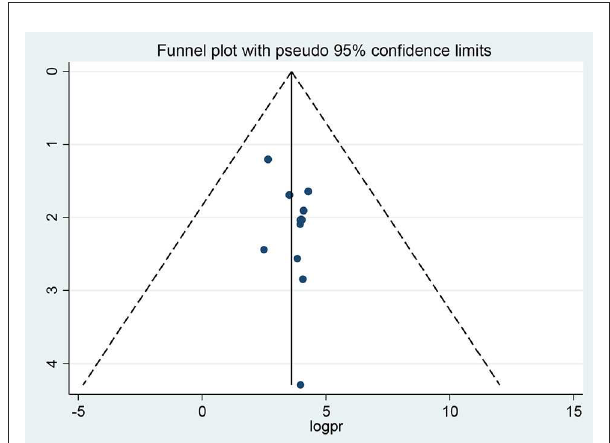
TABLE 3 Sensitivity analysis of pooled prevalence with each study removed one by one.